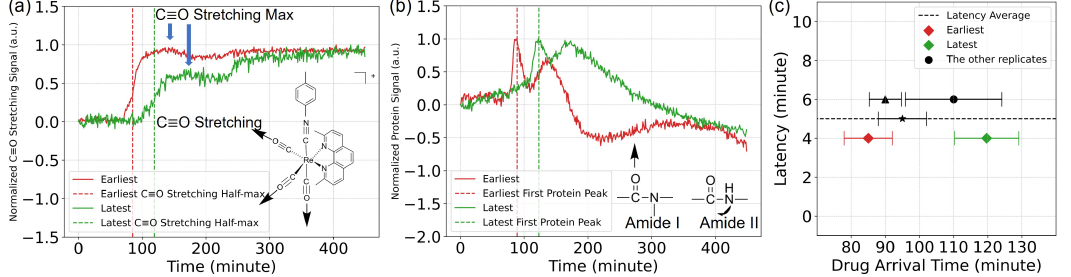
Figure 3. ( a ) Normalized C ≡ O stretch (IR-tag) signals for two representative measurements with different drug arrival times: the earliest (red line) and the latest (green line). Dashed vertical lines: arrival times t arr of the drug (see text for definition). Inset: molecular structure of TRIP and the stretches of its C ≡ O moiety. ( b ) Same as ( a ), but for the corresponding protein signals S prot ( t ) . Inset: amide I and II vibrations. ( c ) Latency ∆ t ≡ t peak − t arr vs arrival t arr times for the five